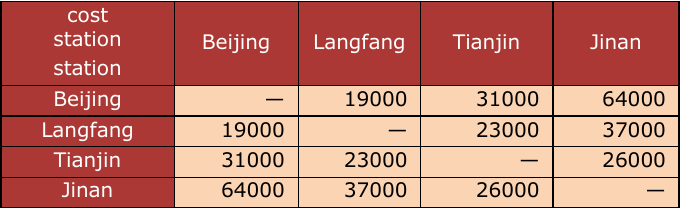
Table 9. Variable operating cost for empty